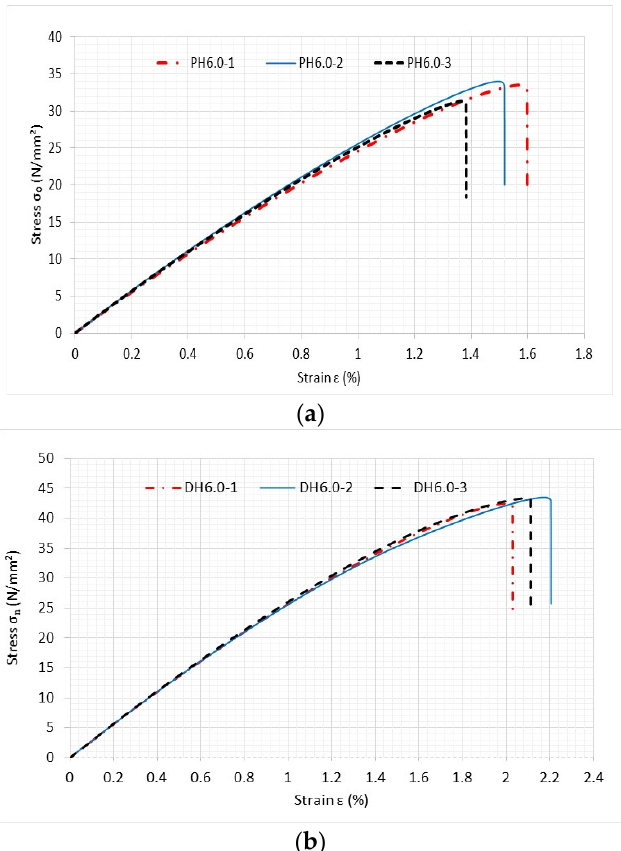
Figure 13. Comparison of stress–strain curves of specimens with ( a ) printed hole and ( b ) drilled hole with 6 mm diameter and 0° print angle.